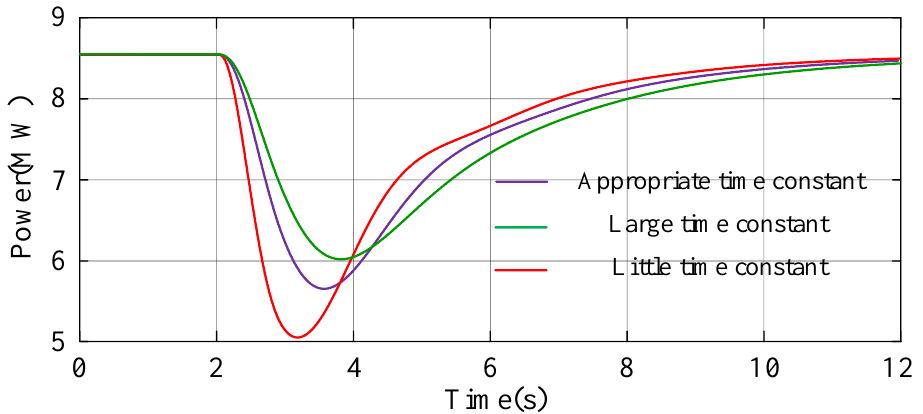
Figure 13. Operation curve of P2H with different time constants of the delay link.